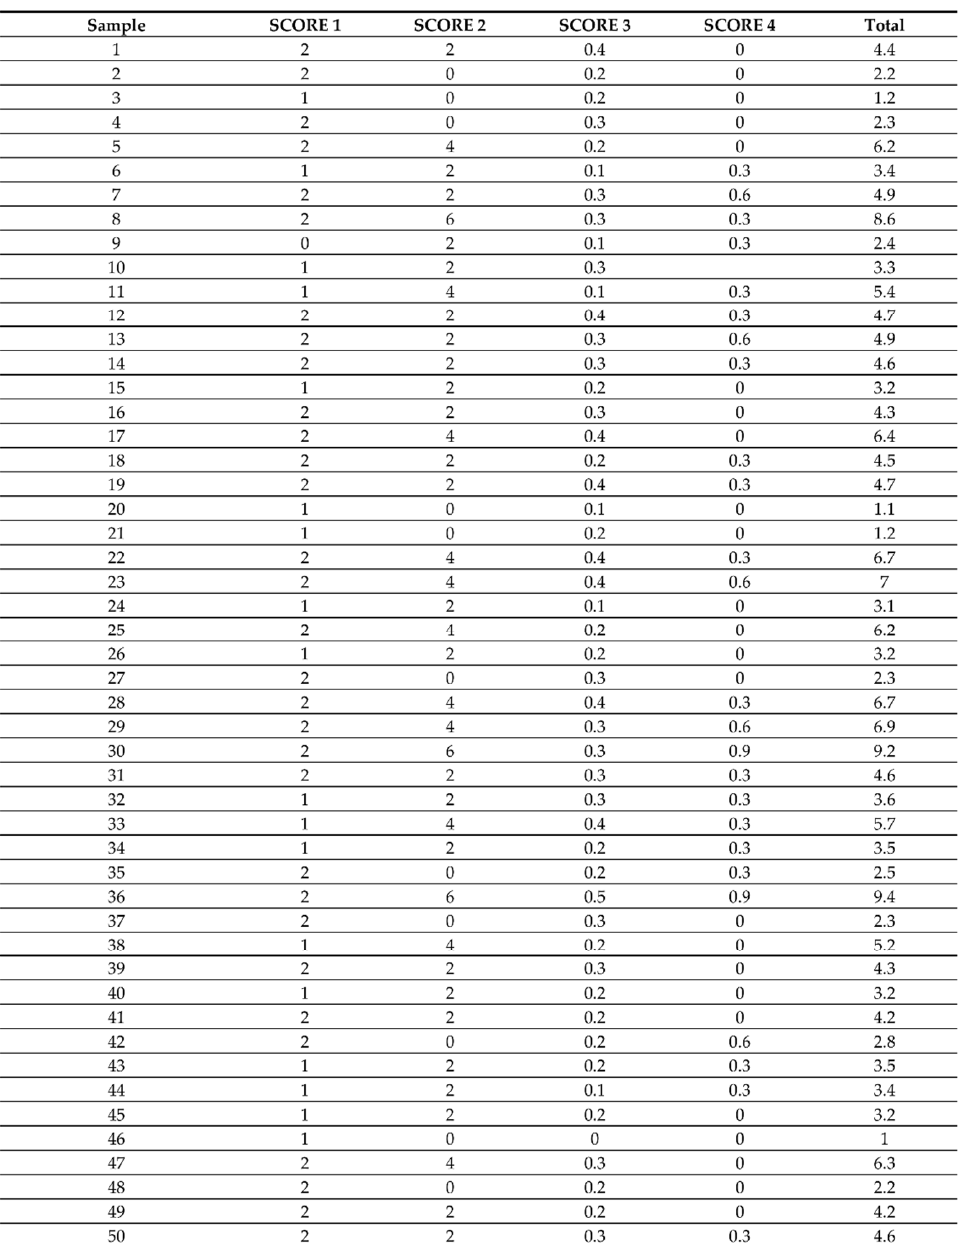
Figure A3. Space Time Permutation Scan Statistic results summary (first 50 samples).